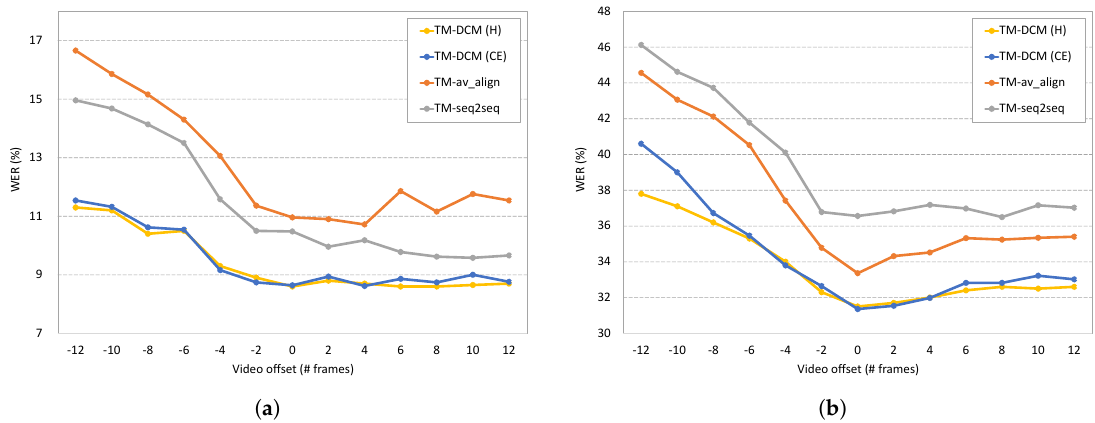
Figure 9. WERs on out-of-sync data for the models using audio–visual modality on the test sets of LRS2-BBC and LRS3-TED datasets with ( a ) clean and ( b ) noisy reverberant audio data. The video frames were shifted by the numbers of frames on the horizontal axes with audio data fixed. The positive offset meant that the audio preceded the video, and the negative offset meant vice